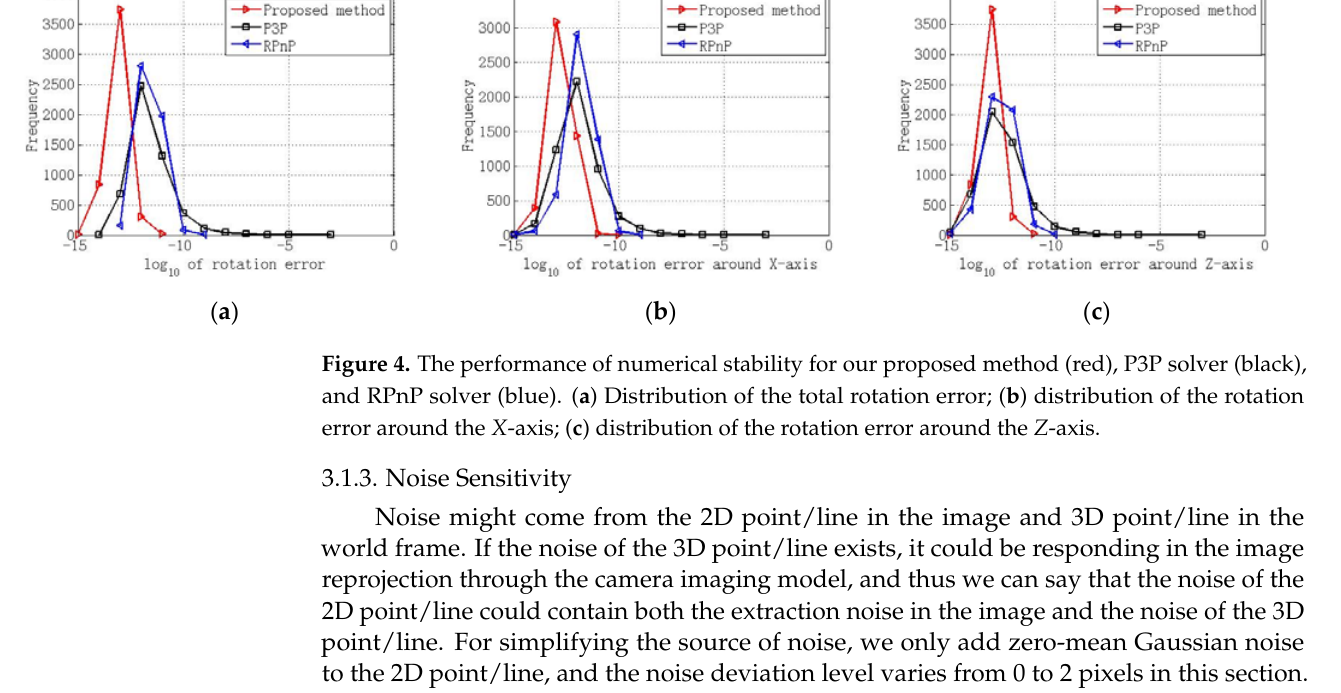
error around the X ‐ axis; ( c ) distribution of the rotation error around the Z ‐ axis.